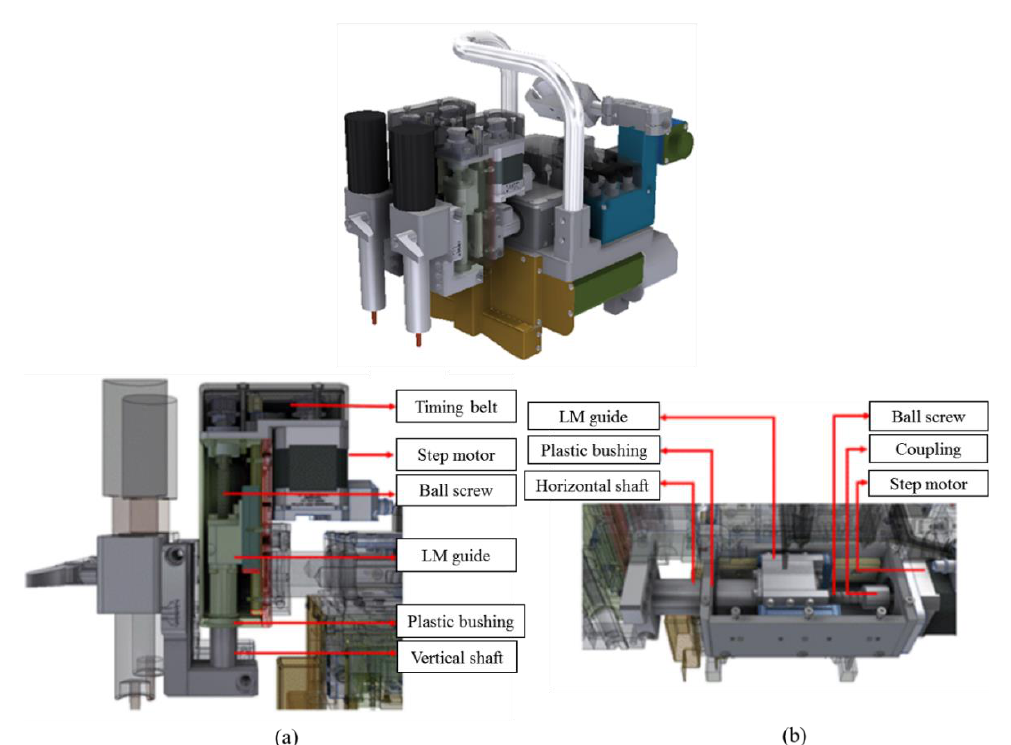
Figure 5. Structure of the welding carriage: ( a ) Vertical view and ( b ) horizontal view.